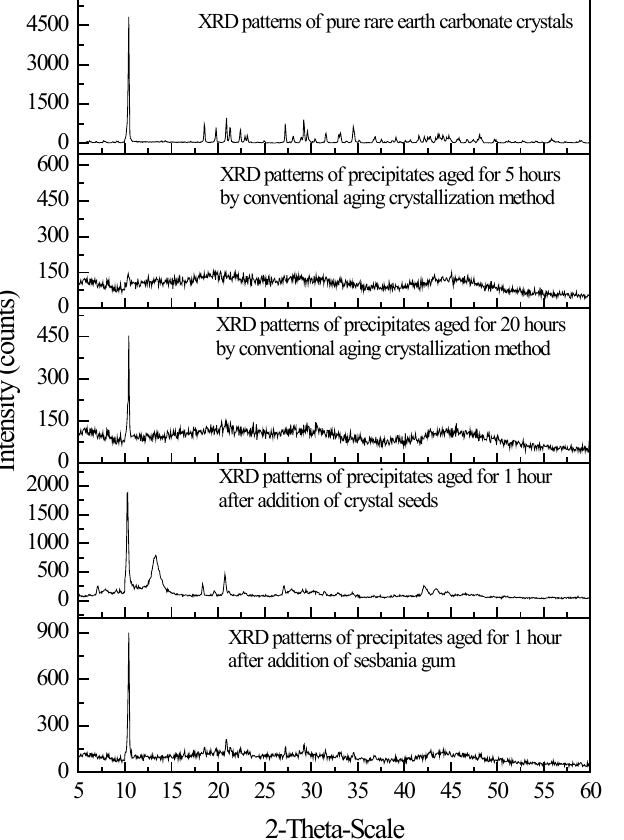
Figure 15. XRD diffraction patterns of rare earth carbonate precipitates under different